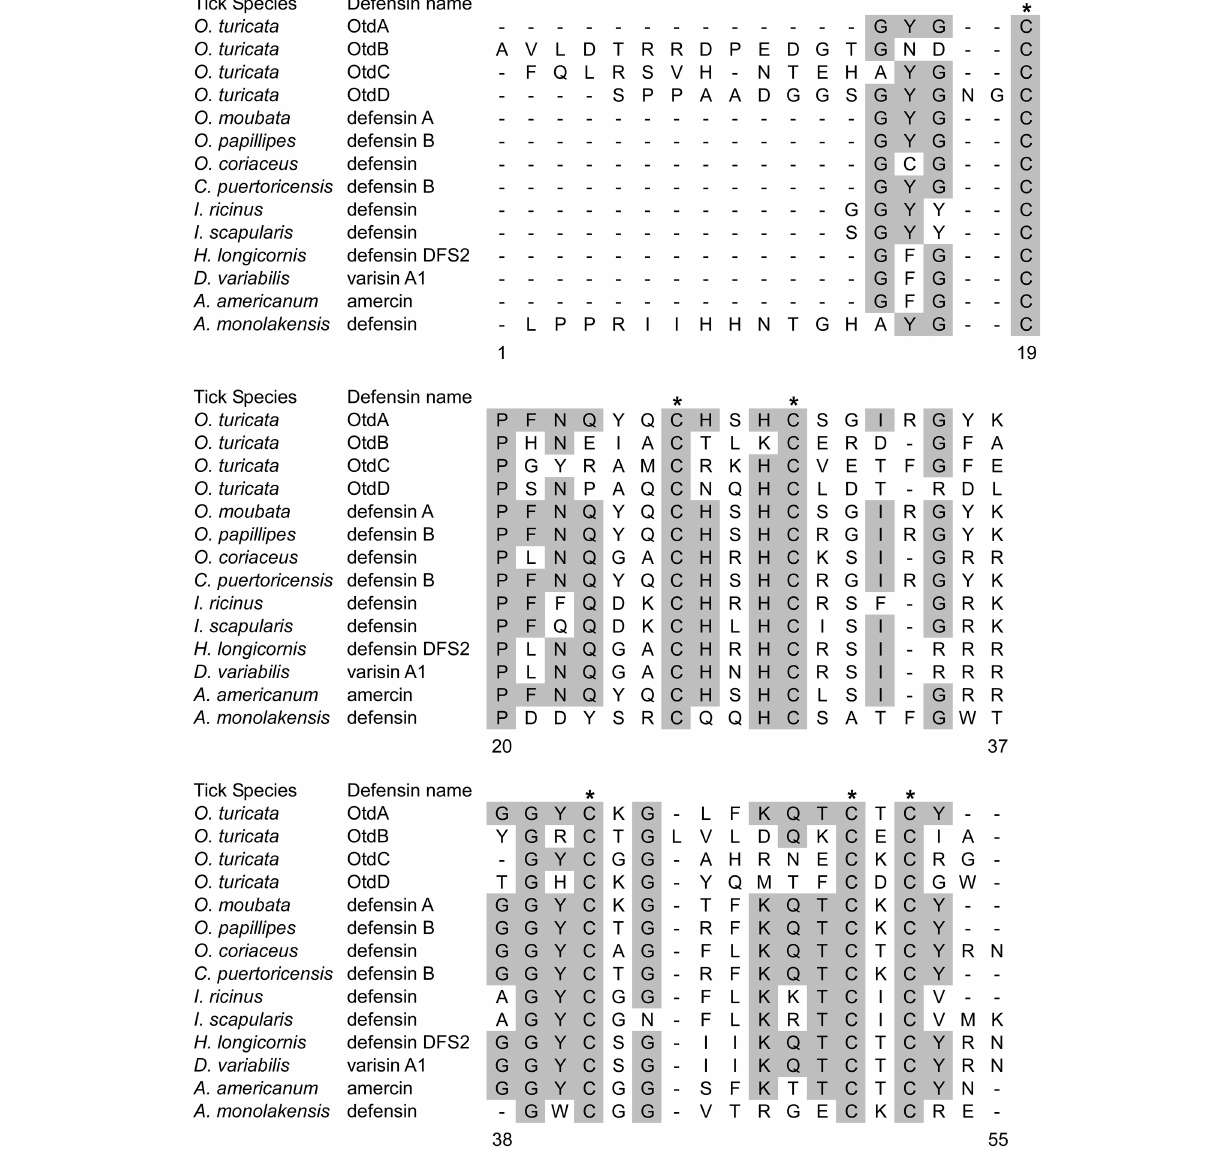
Frontiers in Cellular and Infection Microbiology |